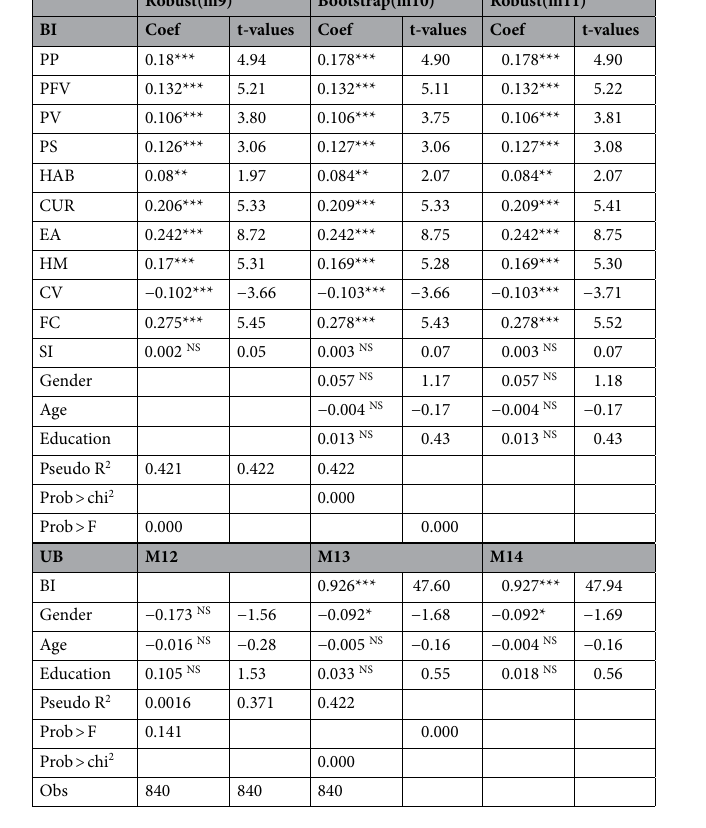
Table 6. Tobit regression. *** p < .01, ** p < .05, * p < .1; NS = Not supported.